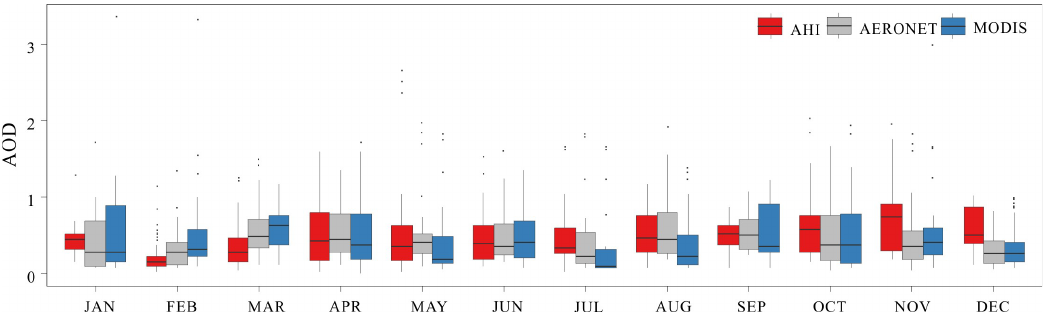
Figure 7. Monthly variations of AHI, MODIS and AERONET AOD at 500 nm in China from February 2018 to January 2019. Lower and upper box boundaries denote the first and third quartiles, and solid line inside box is median value.